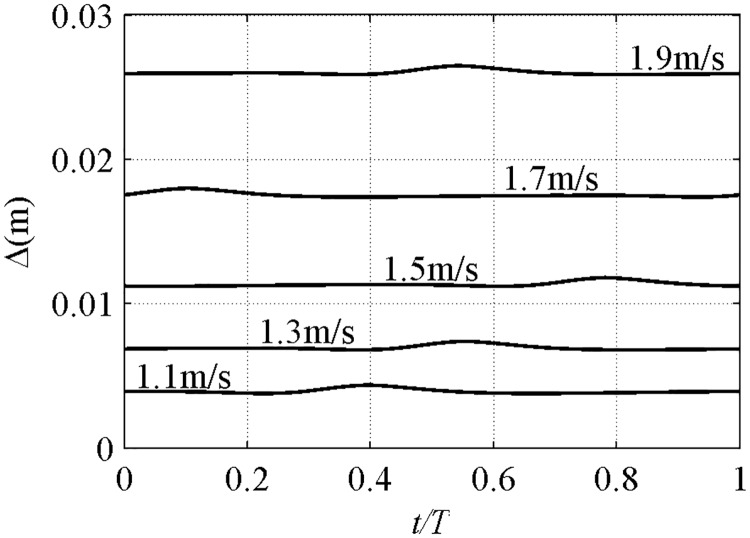
Phase-shift in Δ with T = 2s, D = 0.16mm, R = 0.6, β = 0.65, Um = [1.1,1.3,1.5,1.7,1.9]m/s.